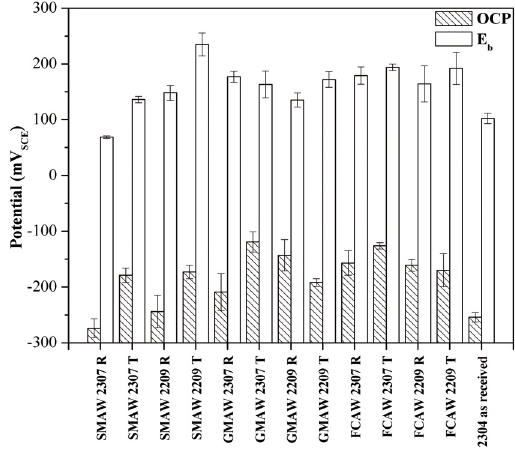
Figure 5: Experimental data for cyclic polarization tests. T – top of weld, R – root of weld